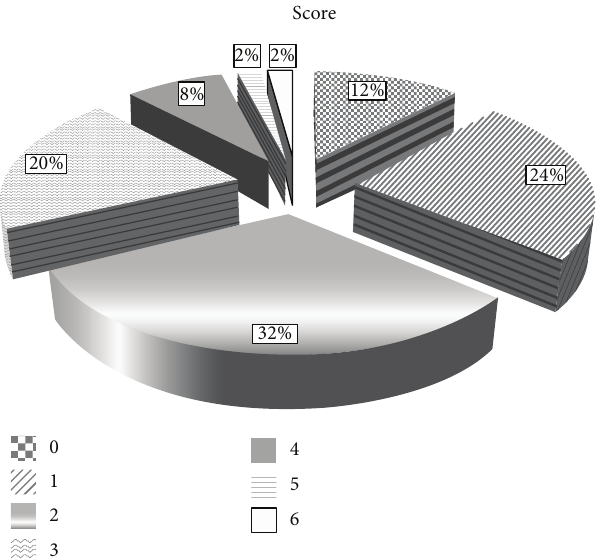
Figure 1: OSA complication score and the number of patients distribution in each group. The description of score was included in the main